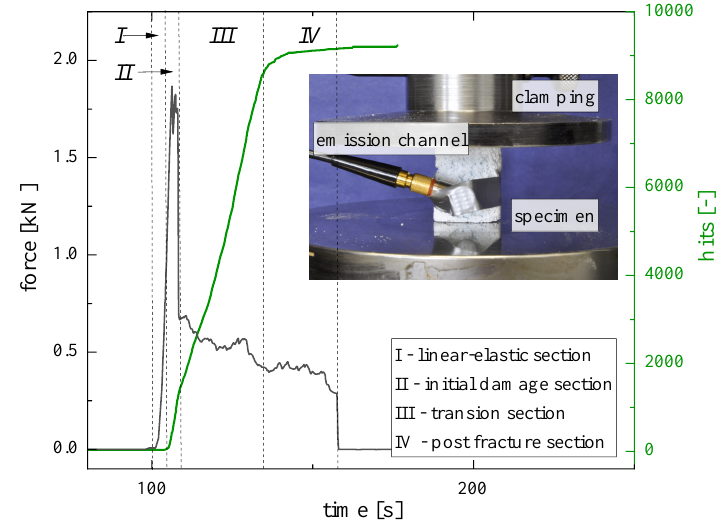
Figure 8. Correlation of force–time curve with acoustic emission